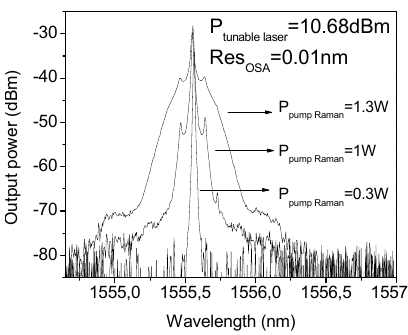
Figure 12. Spectrum of the tunable laser after 250 km.